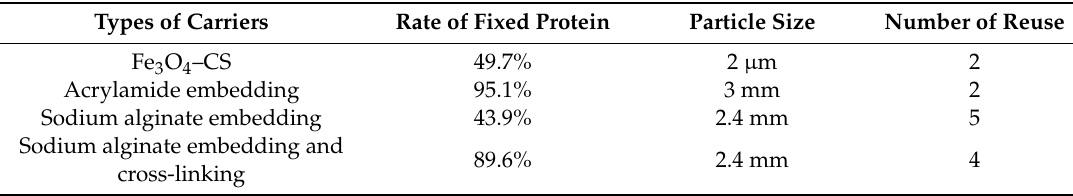
Figure 2. The form of immobilized sialidase with different methods: ( a ) the TEM image of magnetic nanoparticles Fe 3 O 4 –CS; ( b ) acrylamide embedding; and ( c ) sodium alginate embedding. Table 2. Parameters for immobilization.